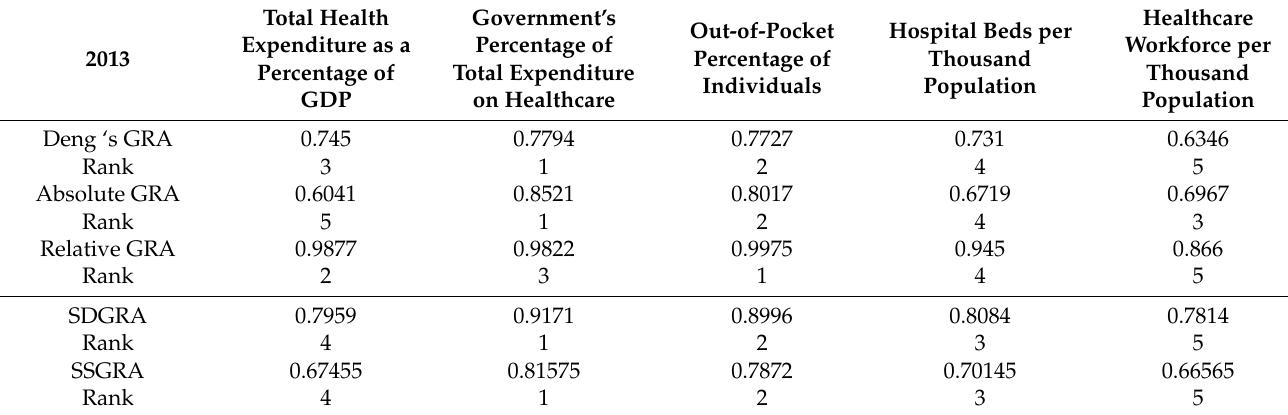
Table 3. Grey Relation Degree and Ranking of the Healthcare Resource Factors for Public Satisfaction with Health System in China (Year 2013).